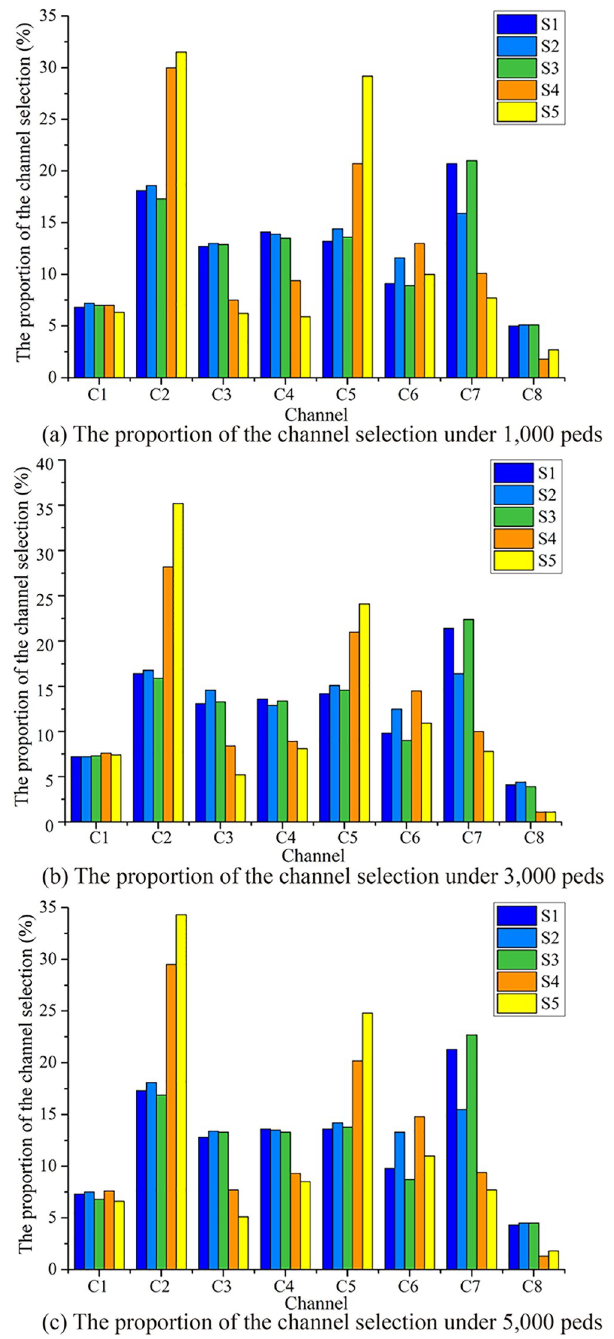
Fig 7. Results of channel selection proportion under five evacuation